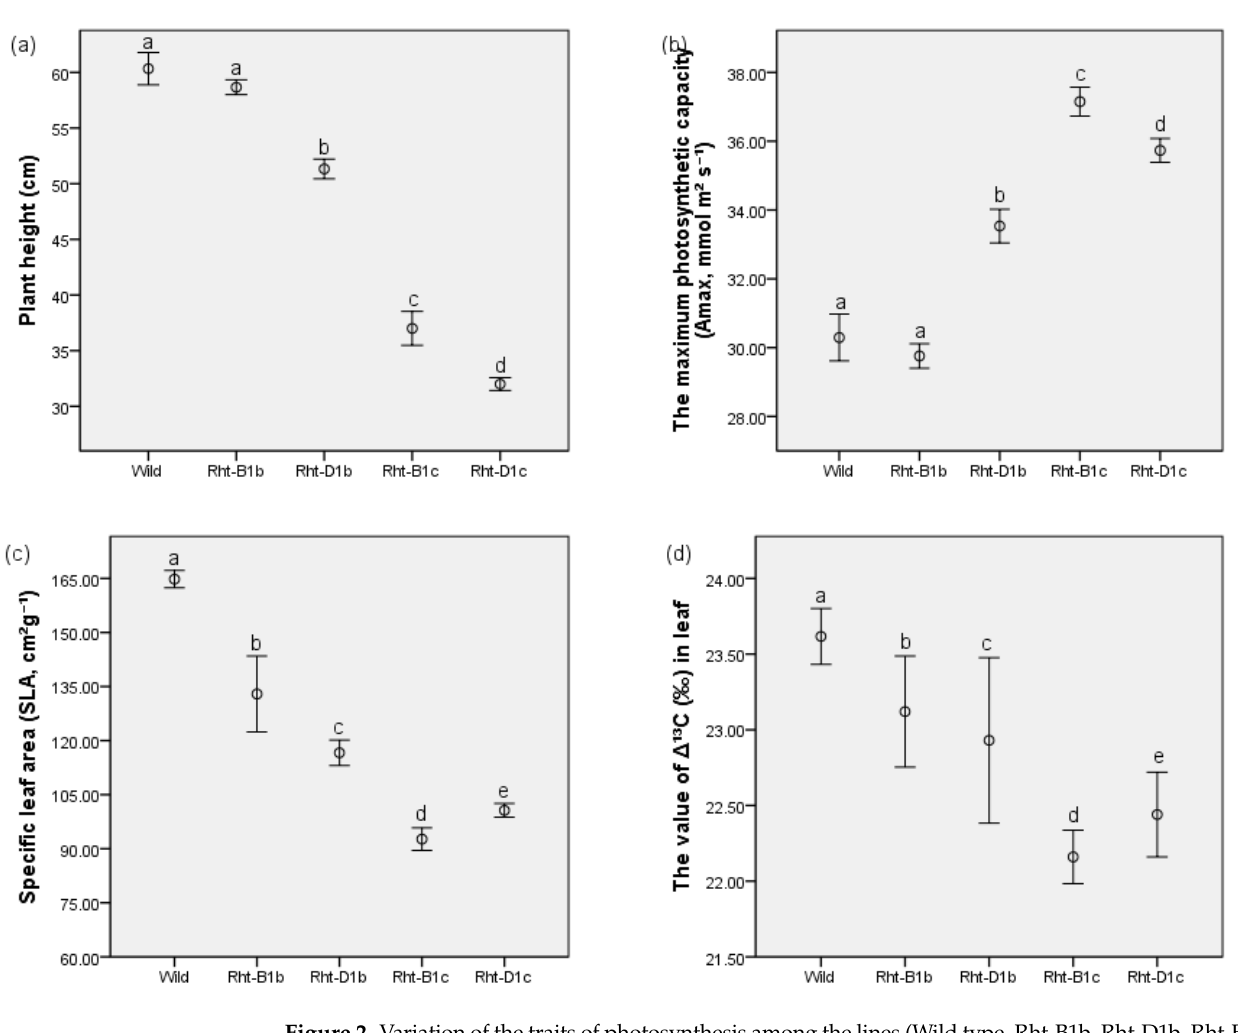
Figure 2. Variation of the traits of photosynthesis among the lines (Wild type, Rht-B1b, Rht-D1b, Rht-B1c, and Rht-D1c) in relation to their height: ( a ) plant height, ( b ) the maximum photosynthetic capacity, ( c ) the specific leaf area, and ( d ) the value of ∆ ¹³C in leaf. Values are means ± SE (n = 8). The bars showing the same letters indicate that their mean values do not statistically differ significantly ( p < 0.01).